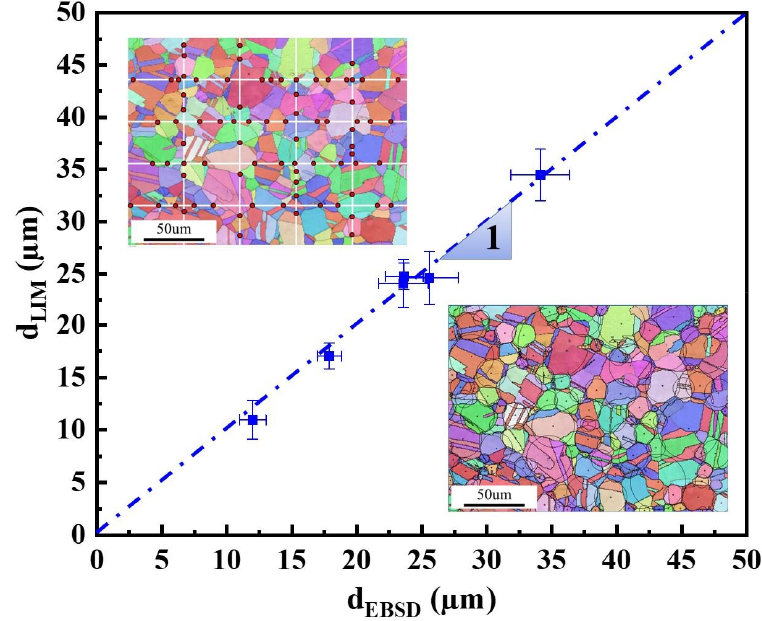
Figure 3. Comparison of the mean grain sizes (excluding twin boundaries) obtained by the linear intercept method ( d LIM ) with those determined by EBSD ( d EBSD ). The EBSD image in the upper left corner and image at the bottom right were taken at the same location and illustrate how grain sizes were determined using the line intercept method and EBSD, respectively.